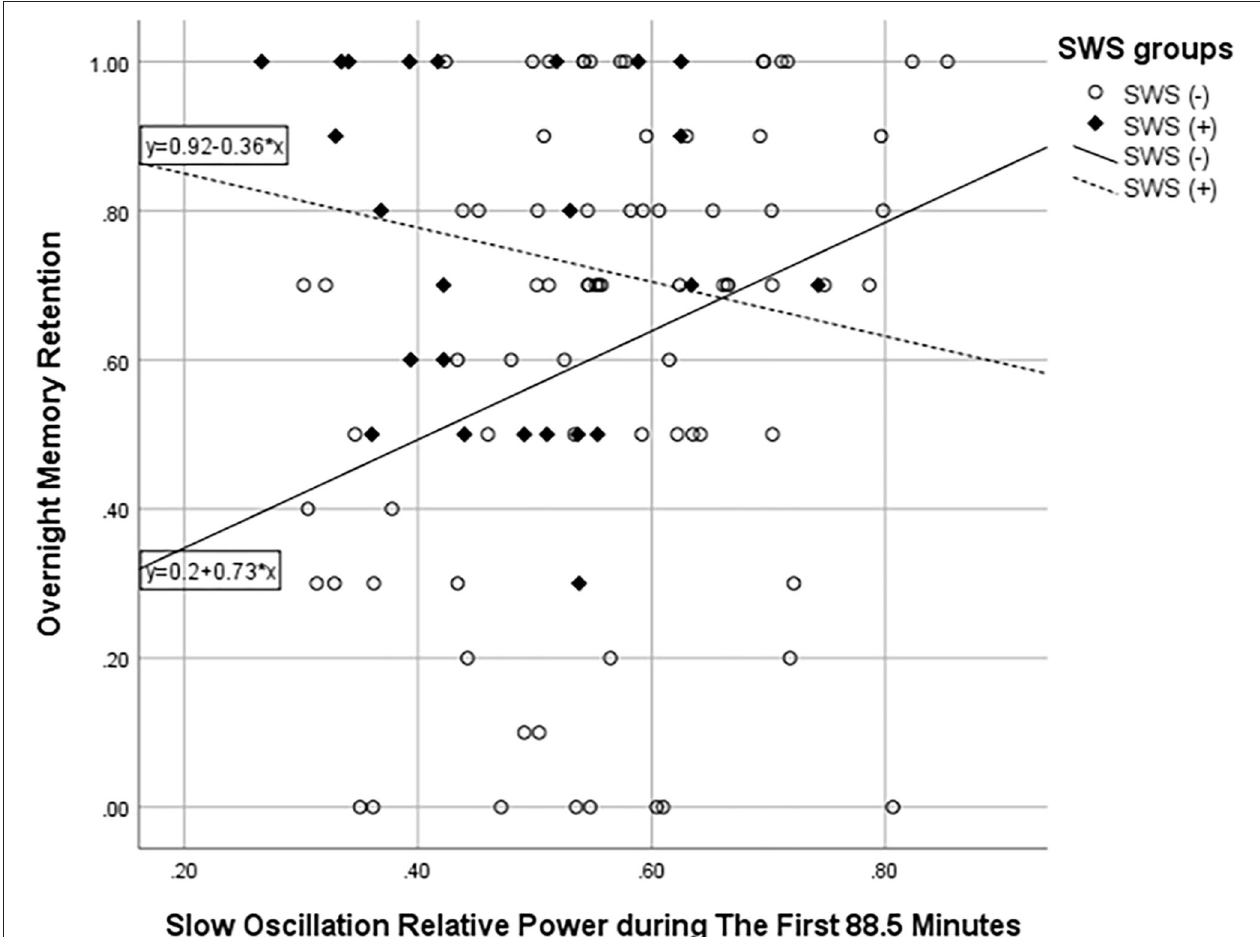
FIGURE 3 | Scatter plot showing the association between slow oscillation relative power during NREM sleep in the first 88.5min and overnight memory retention. ◦ represents the SWS (–) group and (cid:7) SWS ( + )